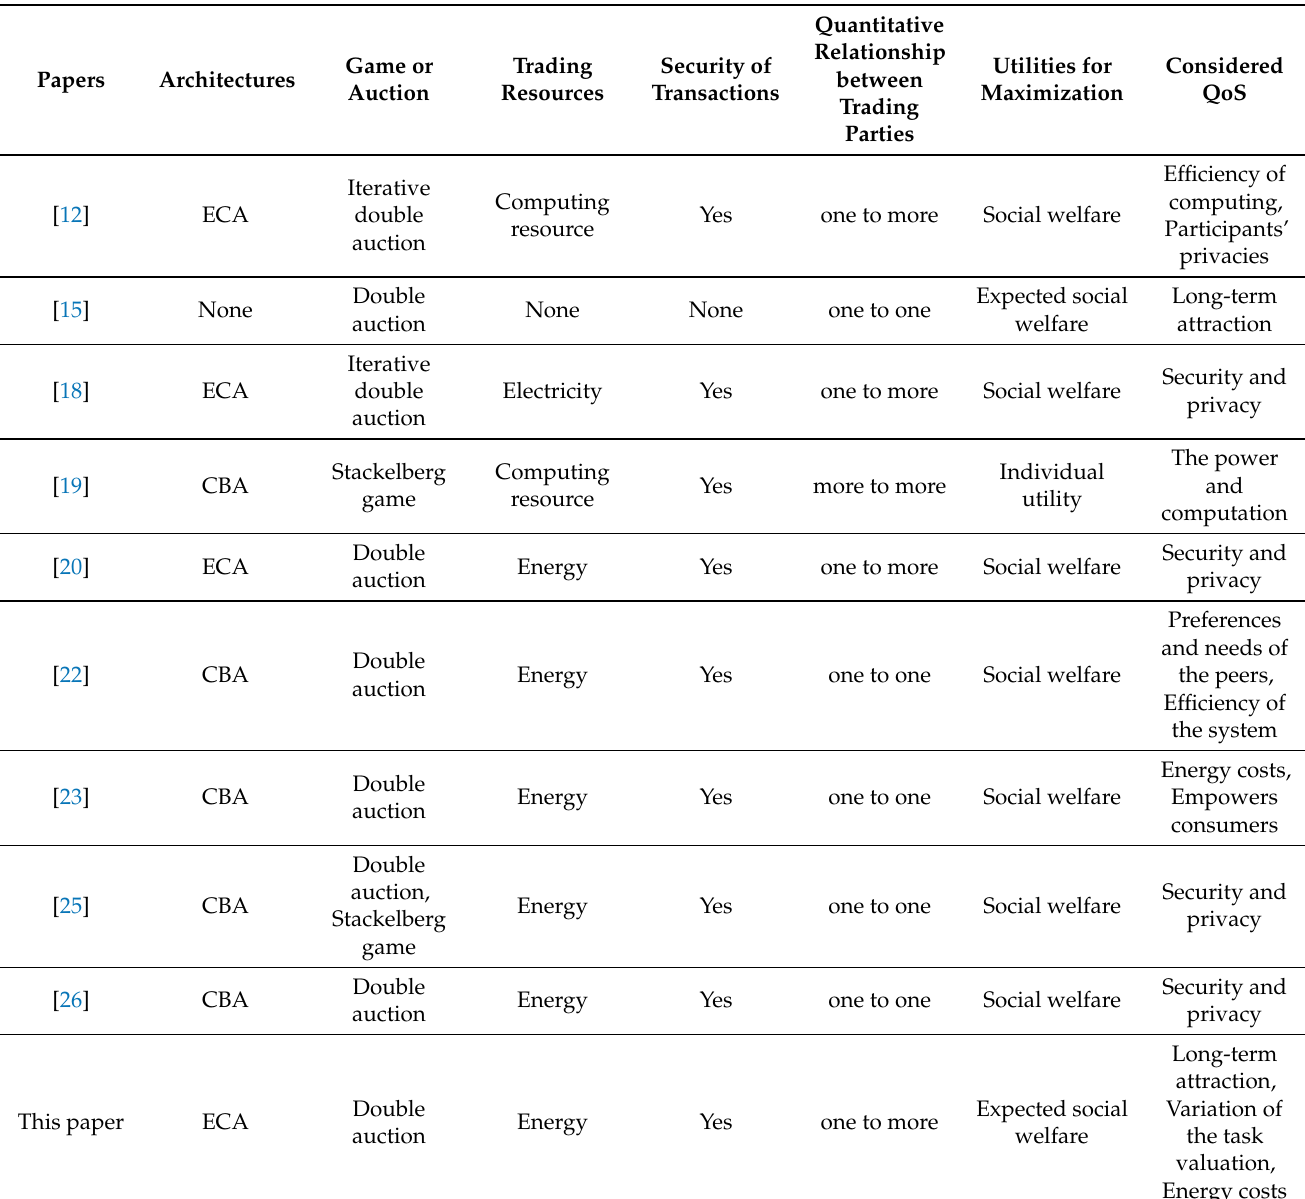
Table 1. Comparison of our scheme with the existing